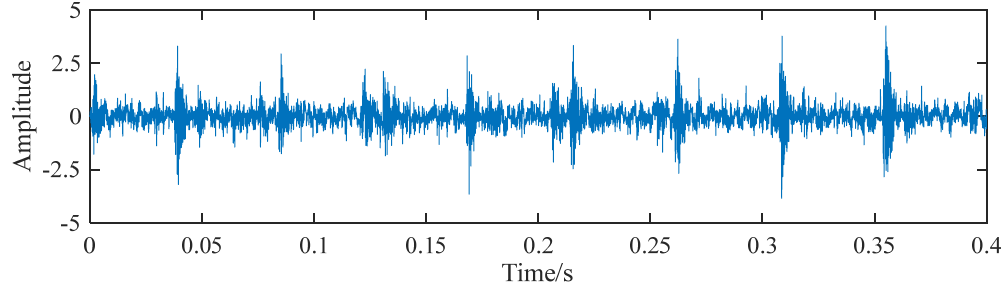
Figure 5. Acceleration signal time domain waveform of inner race failure bearing.